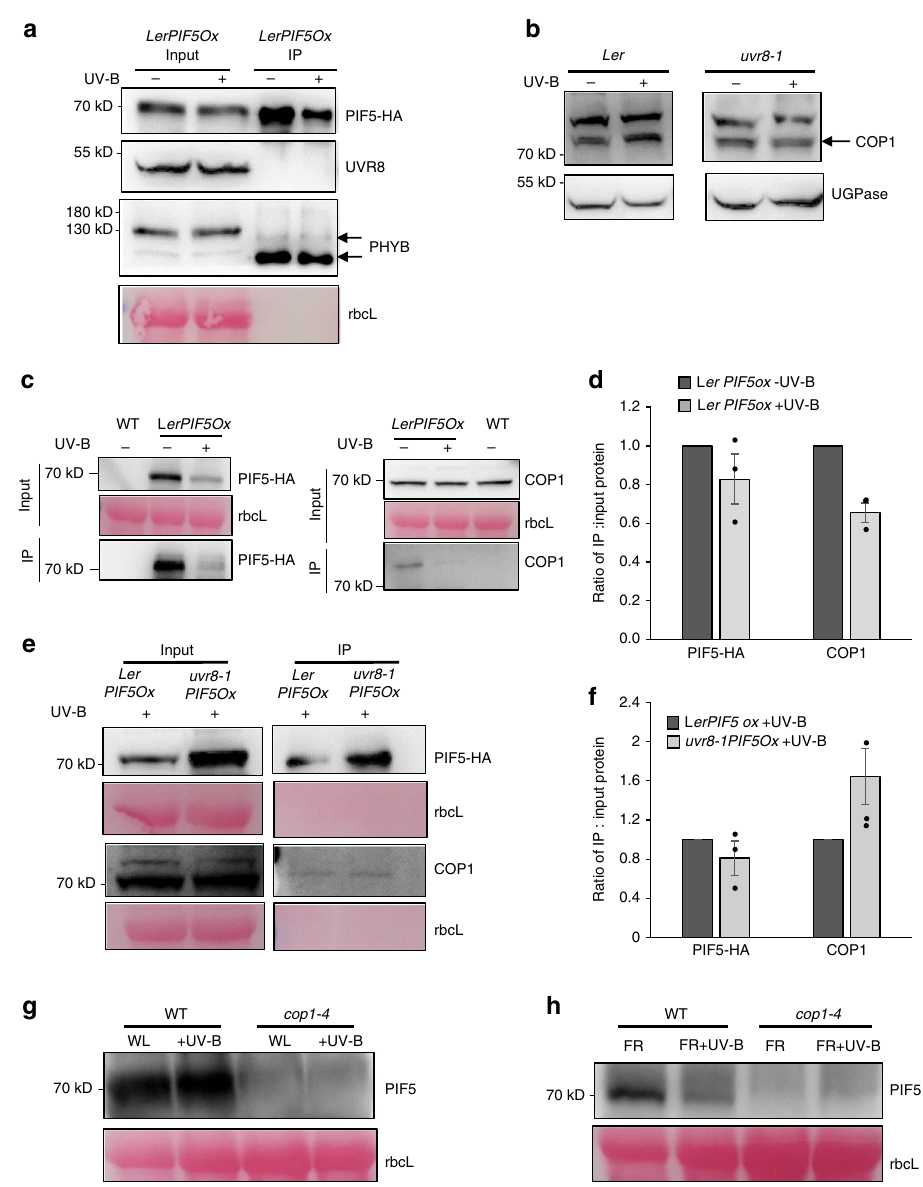
Fig. 5 PIF5 does not interact with UVR8 but binds to COP1, destabilising PIF5. a Co-IP assay showing that PIF5 does not interact with UVR8 in planta . LerPIF5Ox Seedlings were grown for 10 days in16 h light/8 h dark cycles before transfer at dawn to high R:FR ± UV-B for 1 h. Total protein extracts were immunoprecipitated with anti-HA beads and immunoblots analysed with anti-HA or anti-UVR8 antibodies. An anti-PHYB antibody was used as positive control for PIF5 immunoprecipitation. Ponceau stained Rubisco large subunit (rbcL) was used as a loading control. b Western blot of COP1 protein abundance in Ler and uvr8-1 . Seedlings were grown as in ( a ) and immunoblots probed with anti-COP1 and anti-UGPase antibodies. c Co-IP assay showing that PIF5 interacts with COP1 in the presence and absence of UV-B. LerPIF5Ox and WT seedlings were grown as in ( a ). Immunoblots were probed with anti- COP1 or anti-HA antibodies. Ponceau staining of the Rubisco large subunit (rbcL) was used as a loading control. d Quanti fi cation of IP/input protein ratio in ( c ) Mean values from three biological repeats are shown. Bars represent SE. e Co-IP assay performed as in ( c ) showing increased PIF5-COP1 complex in uvr8-1 mutants in UV-B. LerPIF5Ox and uvr8-1PIF5Ox seedlings were grown as in ( a ). f Quanti fi cation of IP/input protein ratio in ( e ). Mean values from three biological repeats are shown. Bars represent s.e.m. g , h Western blots of PIF5 protein abundance in 10-day-old Col-0 and cop1-4 seedlings. Plants were grown in 16 h light/8 h dark cycles before transfer at dawn to high R:FR (WL) ± UV-B ( e ) or low R:FR (FR) ± UV-B ( f ) for 2 h. Immunoblots were probed with an anti-PIF5 antibody. Ponceau staining of the Rubisco large subunit (rbcL) was used as a loading control. Source data are provided as a source data fi with previous observations, PIF5 levels were reduced in UV-B- interacts with PIF5 in light-grown plants and the impact of UV-B treated LerPIF5Ox seedlings and PIF5-HA immunoprecipitations on this process. Co-IP assays were performed with LerPIF5Ox (Fig. 5c). PIF5-COP1 complexes were detected in UV-B-treated seedlings treated with and without UV-B for 1 h (Fig. 5c, d) and and -untreated seedlings, with reduced abundance following UV-B-treated uvr8-1PIF5Ox seedlings (Fig. 5e, f). PIF5 degra- UV-B treatment (Fig. 5c, d). In accordance with antibody control dation is clearly visible at this timepoint (Fig. 2). No PIF5 or tests (Supplementary Fig. 6a), elevated PIF5 was detected in COP1 bands were detected in WT controls (Fig. 5c)). Consistent